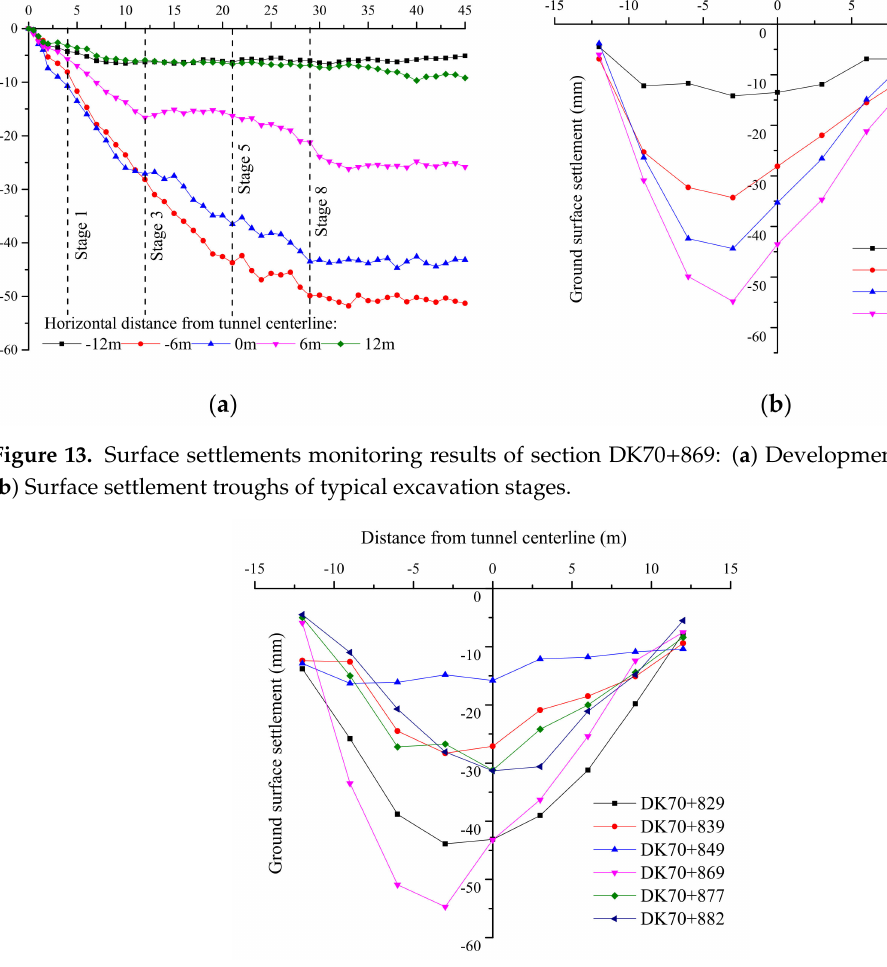
Figure 14. Final surface settlement troughs of each